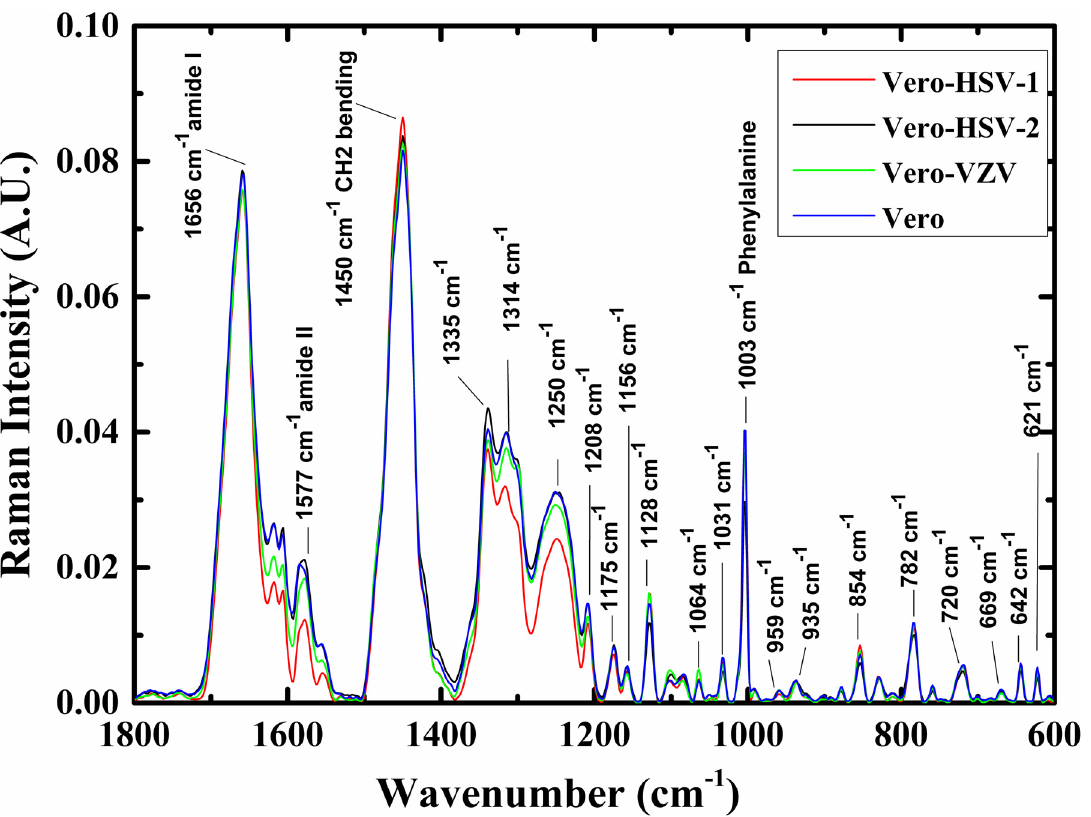
Fig 1. Average spectra of Raman shift bands. Four average spectra of Vero cells, HSV-1 infected Vero cells, HSV-2 infected Vero cells, and VZV infected Vero cells in the 600 – 1800 cm -1 range. All the spectra were manipulated and normalized using OPUS software. The major Raman shifts are labeled in the